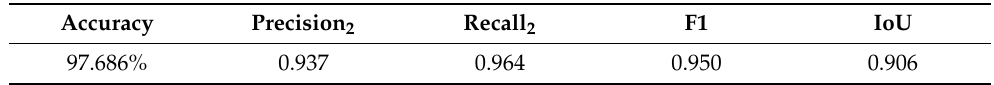
Table 5. Performance of the model on the test set.